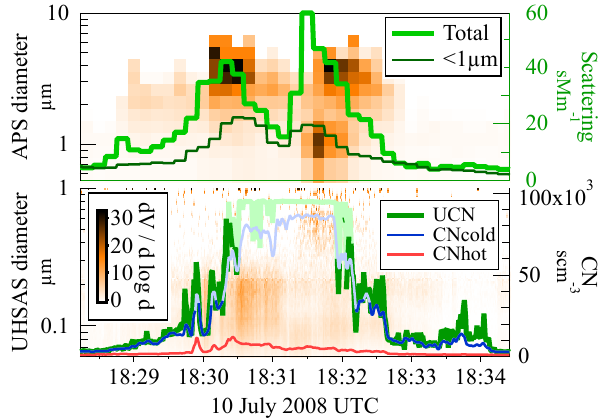
Figure 6. Aerosol volume superimposed on some of the data from Fig. 5. The upper panel shows total and submicron light scattering at 550nm and the coarse aerosol volume distributions measured by the APS. The lower panel shows UCN, CNcold and CNhot over sub-µm volume distribution from the UHSAS. Pale traces show UCN and CNcold saturation; true values are